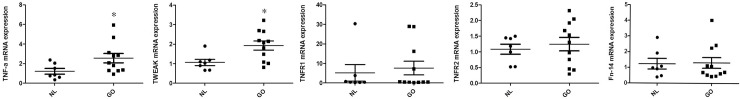
TNFA, TWEAK, TNFR1, TNFR2, and TNFRSF12A (Fn14) expression in GO and non-GO orbital tissues.Transcript levels of TNFA as well as TWEAK and its receptors TNFR1, TNFR2, and TNFRSF12A (Fn14) were compared between GO (n = 11) and non-GO (n = 7) orbital tissues by real-time PCR. TNFA and TWEAK were upregulated in GO as compared to non-GO tissue. *P < 0.05 vs. non-GO control. NL, normal non-GO subjects.